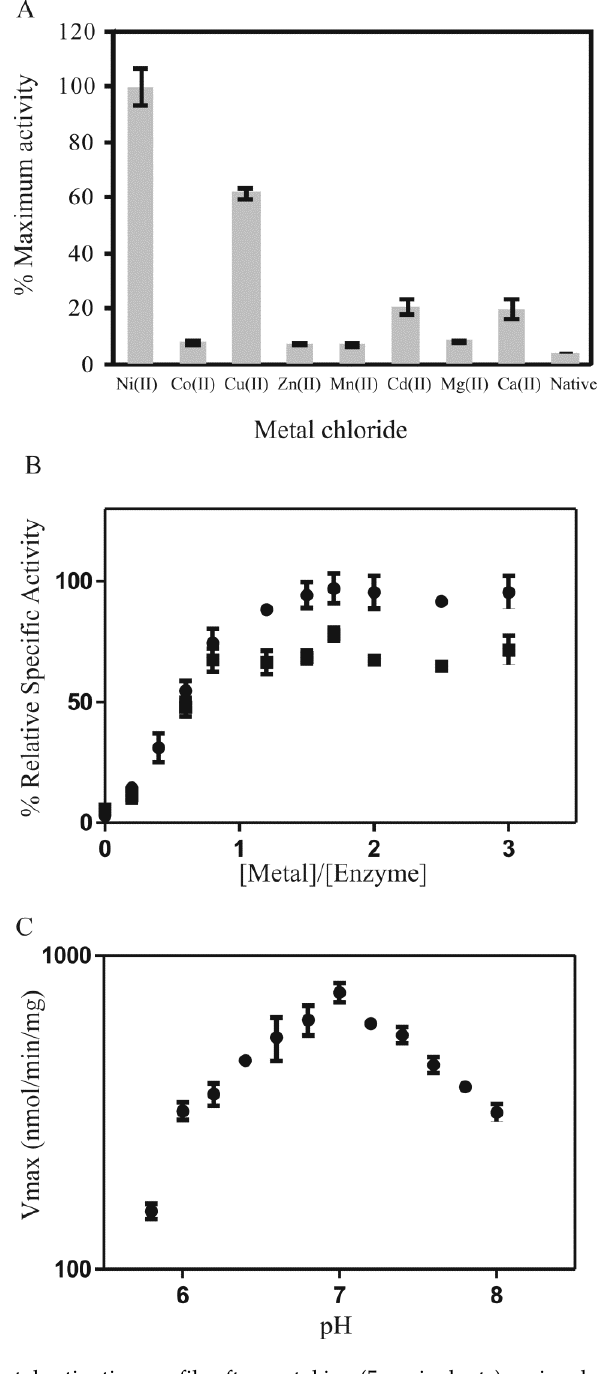
Figure 6. ( A ) PDO metal activation profile after metal ion (5 equivalents) preincubation of the apo-form of the enzyme with metal chloride (conditions: PDO (3.1 µg in 200 µL) incubated with metal chlorides overnight at 4 °C); ( B ) % Relative specific enzyme activity of PDO versus metal ion titration with ( ) Ni 2+ and ( ) Cu 2+ ; ( C ) pH dependency of PDO (3.125 µg in 200 µL assay; 5 equivalents NiCl 2 ) with the substrate MG-tMSH (0.5 mM, K d = 3.3 mM) that was incubated for 30 min in potassium phosphate buffer at various pH (5.8 – 8) at 25 °C.